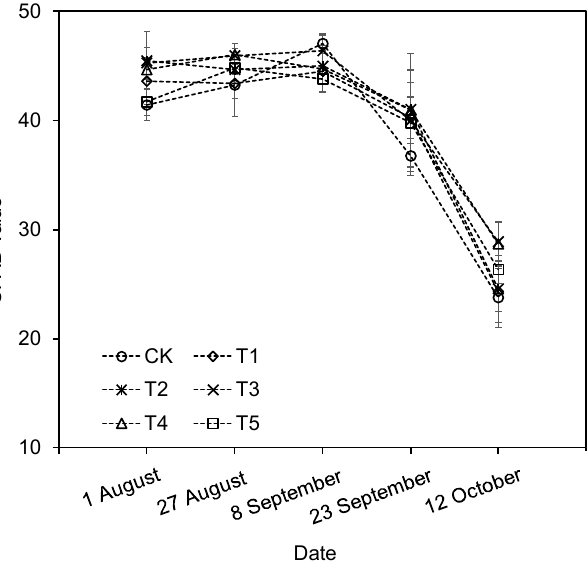
Figure 1. Variation of SPAD value in rice growth period under different ZnO NPs application amounts. Table 6. Rice quality under different ZnO NPs application